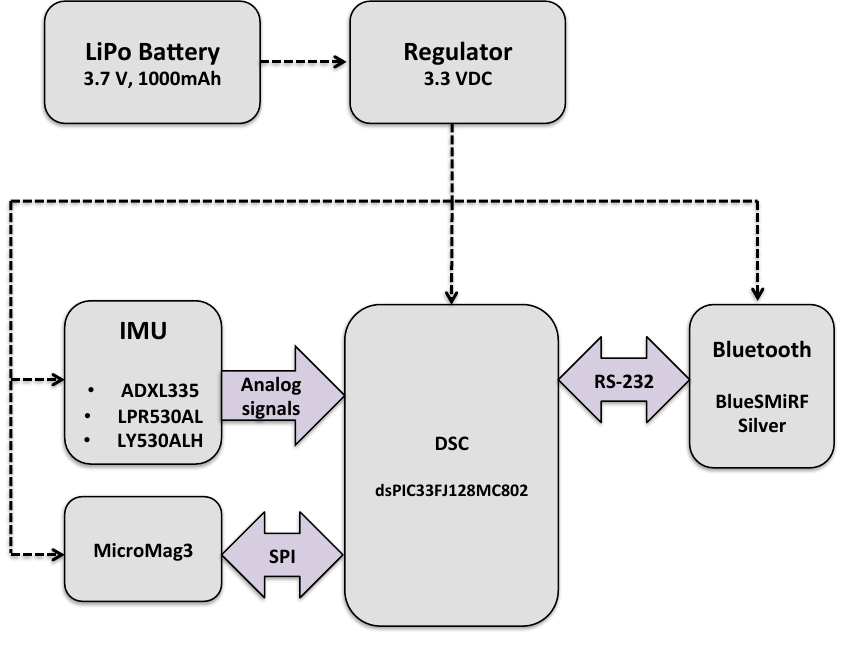
Figure 4. Block diagram for the Attitude and Heading Reference System (AHRS) prototype.